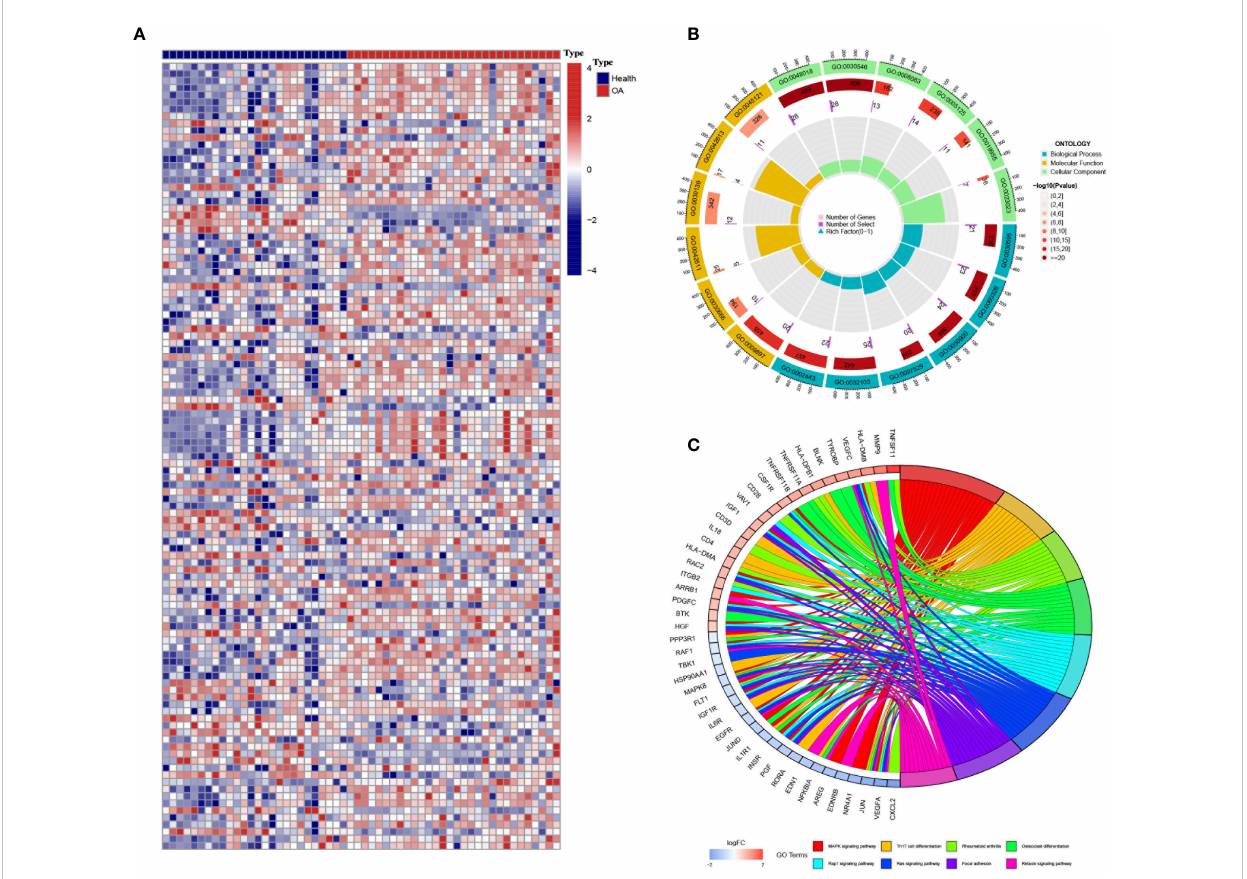
FIGURE 1 Differentially expressed immune genes in osteoarthritis (OA). (A) The heatmap shows the differentially expressed immune genes between OA and control samples (GSE55235). (B, C) Gene Ontology (B) and Kyoto Encyclopedia of Genes and Genomes (C) enrichment analyses revealed the biological function and downstream pathways of the differentially expressed immune